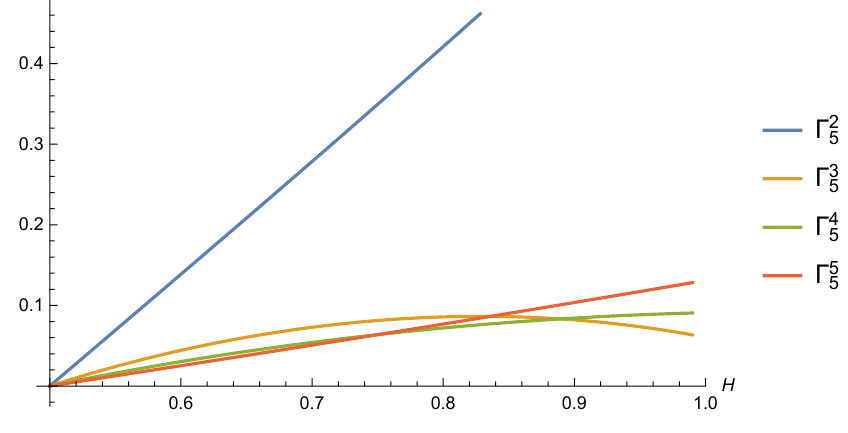
, Γ 3 , Γ 4 , and Γ 5 5 5 5